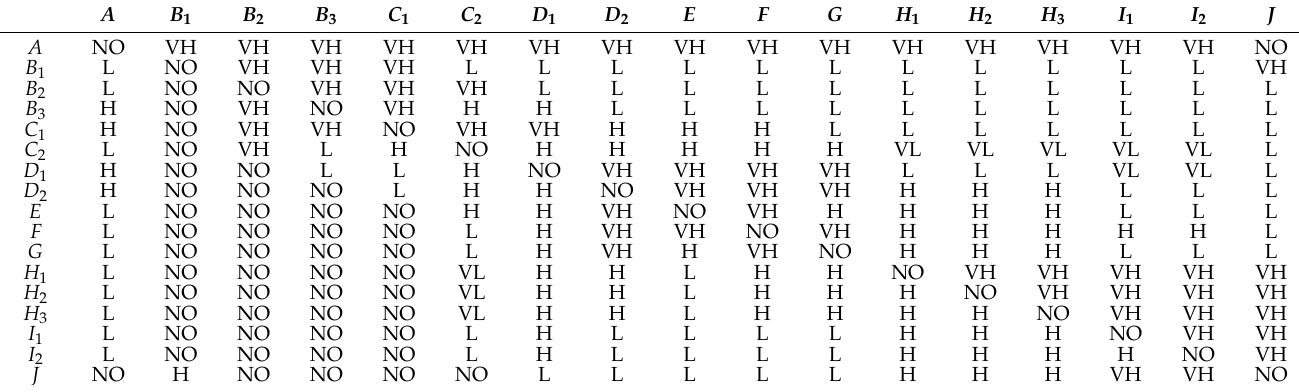
Table 3. Linguistic evaluations of influence unanimously attributed by the interviewed